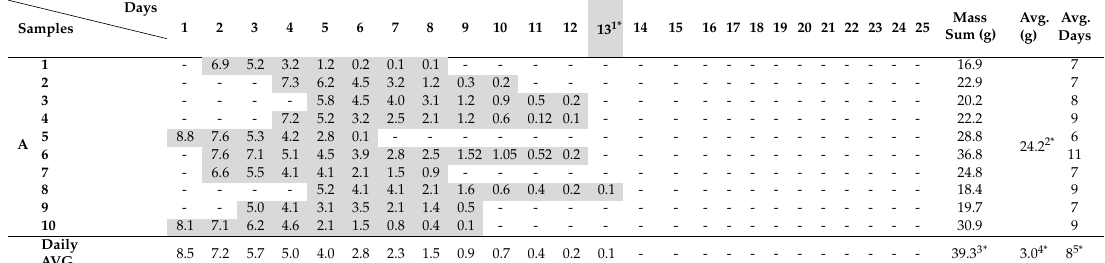
Table 5. Oil leakage mass measurement result (specimen A).